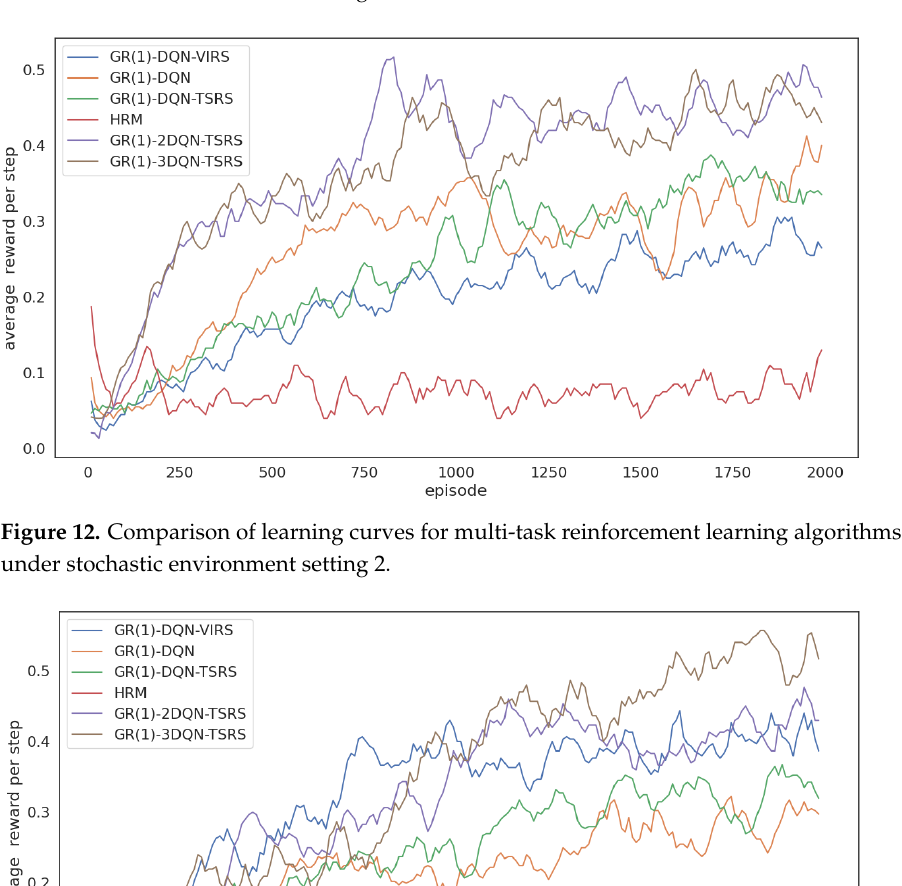
Figure 11. Comparison of learning curves for multi-task reinforcement learning algorithms with ϕ 2 under stochastic environment setting 1.